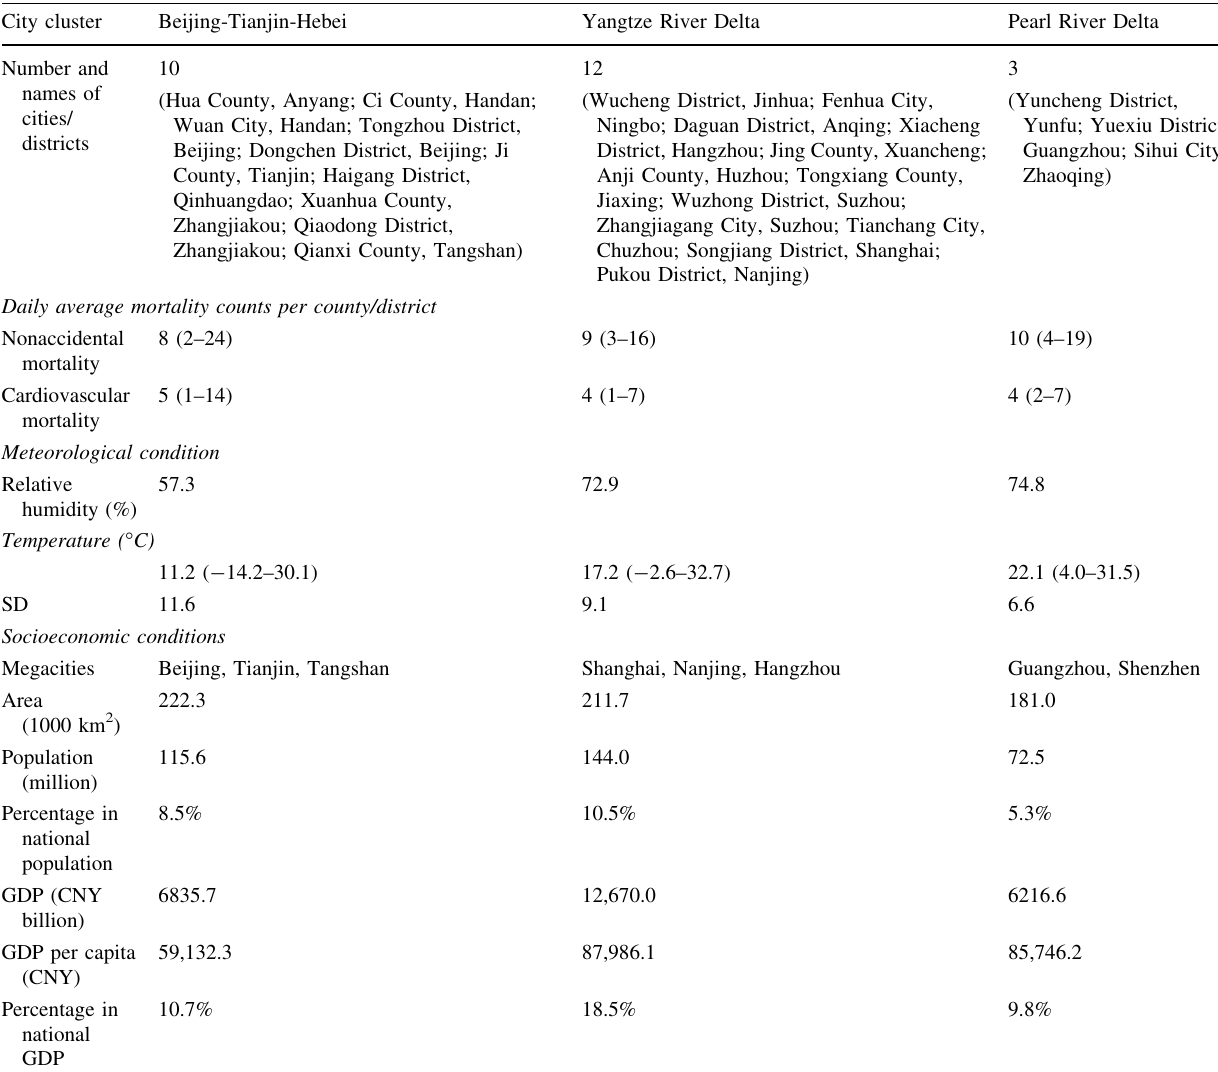
Table 1 Summary mortality, weather statistics, area, population, and economic data in three city clusters in eastern China City